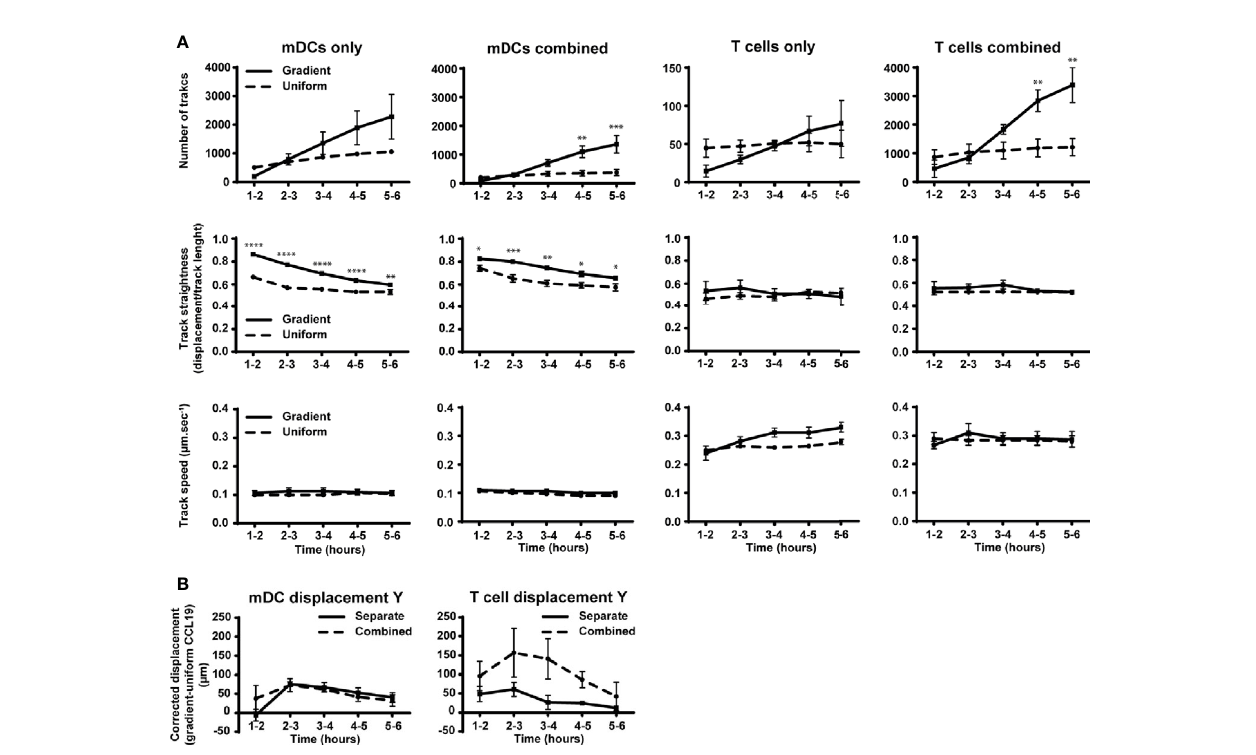
FIGURE 4 | Migration behavior of DCs is not altered by the presence of T cells while the number of T cells and their displacement toward CCL19 is increased in the presence of mDCs. (A) Graphs showing the number of tracked cells, track straightness and track speed of mDCs and T cells over time in response to a CCLl9 gradient or uniform 100 ng mL -1 CCL19 concentration. (B) Graphs showing the displacement of mDCs and T cells towards a gradient of CCL19. The displacement was analyzed by taking the average displacement of T cells toward a CCL19 gradient and subtracting the average displacement of T cells in the same direction in a uniform CCL19 concentration. Data are combined from three independent experiments and are presented as mean +/ SEM. Results were analyzed using multiple t-tests with the assumption that all populations have the same scatter and was corrected for multiple comparisons using the Holm-Sidak method. *P-value < 0.05, **P-value < 0.01, ***P-value < 0.001, ****P-value <